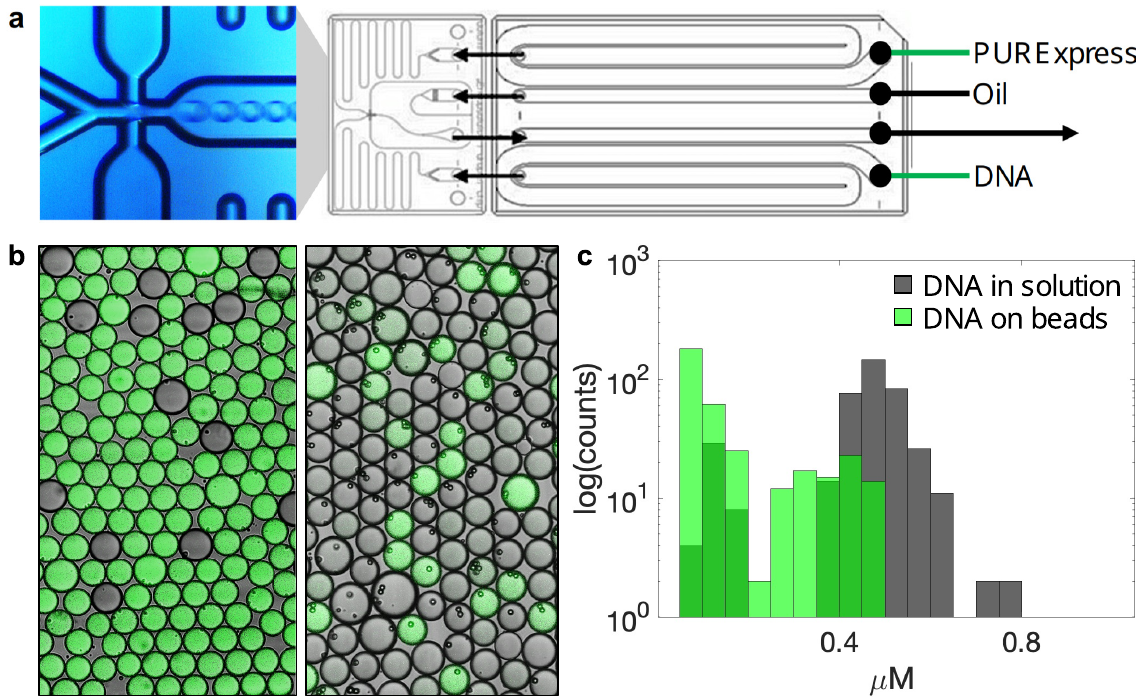
Fig 3. Droplet-based expression of mNeonGreen fluorescent protein from DNA in solution and from single DNA-coated beads. (a) Schematic microfluidics setup with the actual droplet generation junction shown on the left. (b) Fluorescent microscopy images of representative droplets with white light transmission channel overlay. Left: expression from DNA in solution, Right: expression from DNA- coated beads. (c) protein concentration distribution over 401 droplets (DNA in solution), and 354 (DNA on beads. One bead per droplet).